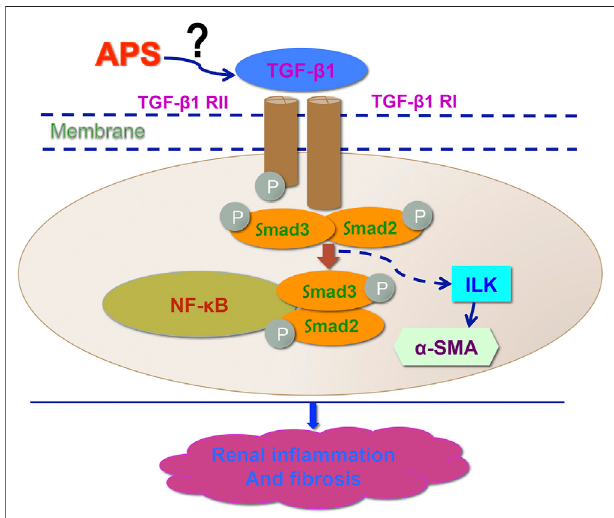
FIGURE 7 | Working model for APS in the regulation of DOCA-induced hypertensive kidney modeling. After treatment with APS reduces the expression of ILK and downregulates the TGF- β /Smad signaling pathway to improvethekidneyfunctionandreducetheinjuryinhypertensivekidney.